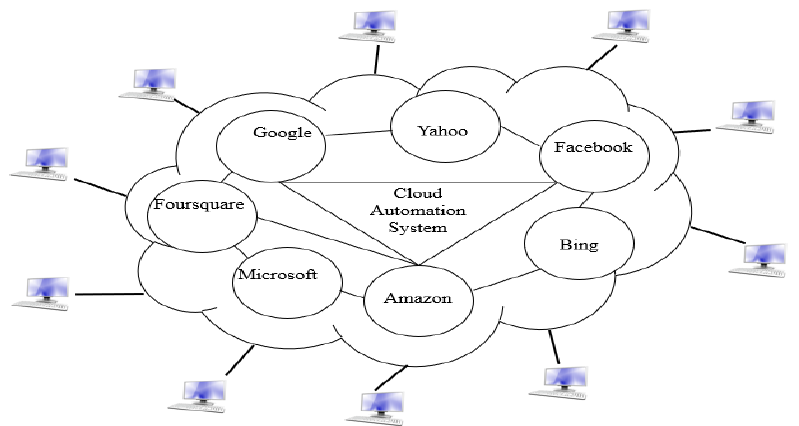
Figure 1. Cloud Recommendation System.